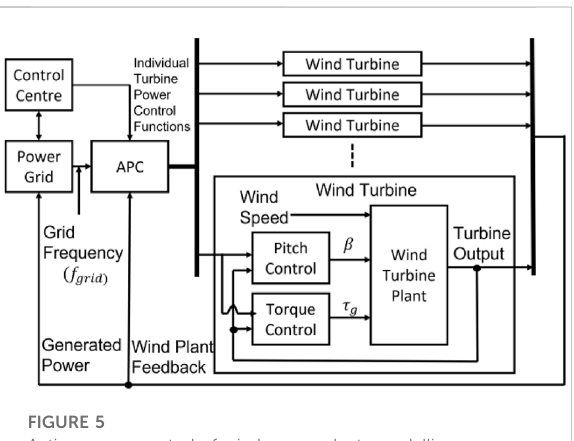
FIGURE 5 Active power control of wind power plants modelling.